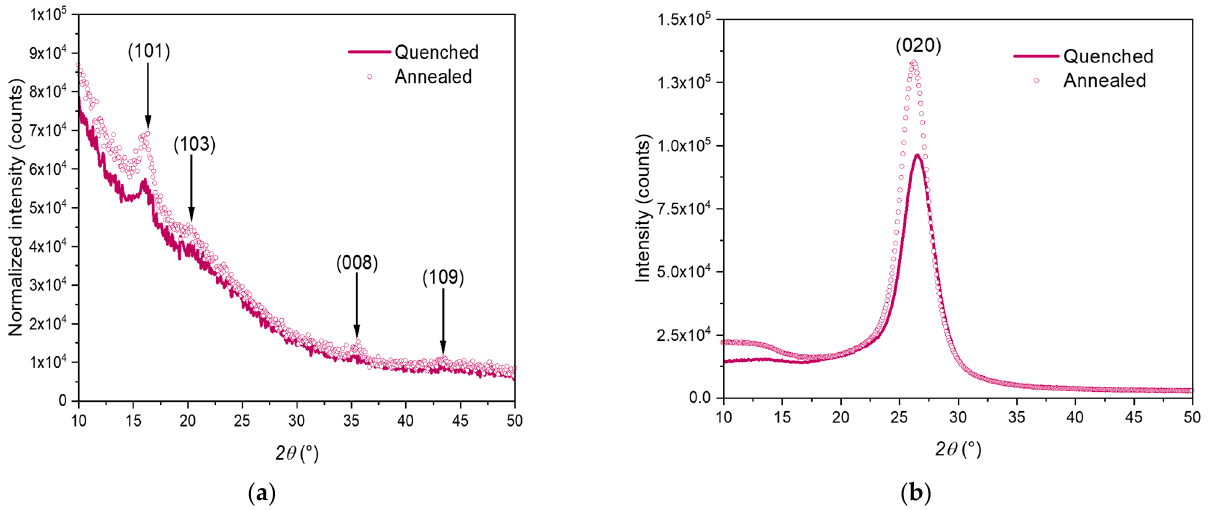
Figure 5. WAXS radial scans in ( a ) transmission and ( b ) reflexion mode for PEF biaxially stretched in simultaneous and balanced conditions, followed by a quenching (lines) or annealing (dots) step.